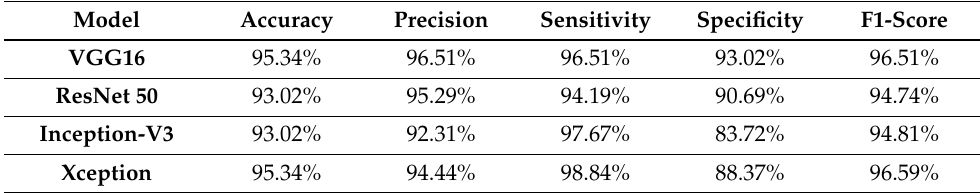
Table 3. Observed results from the DL models for the prediction of PD.